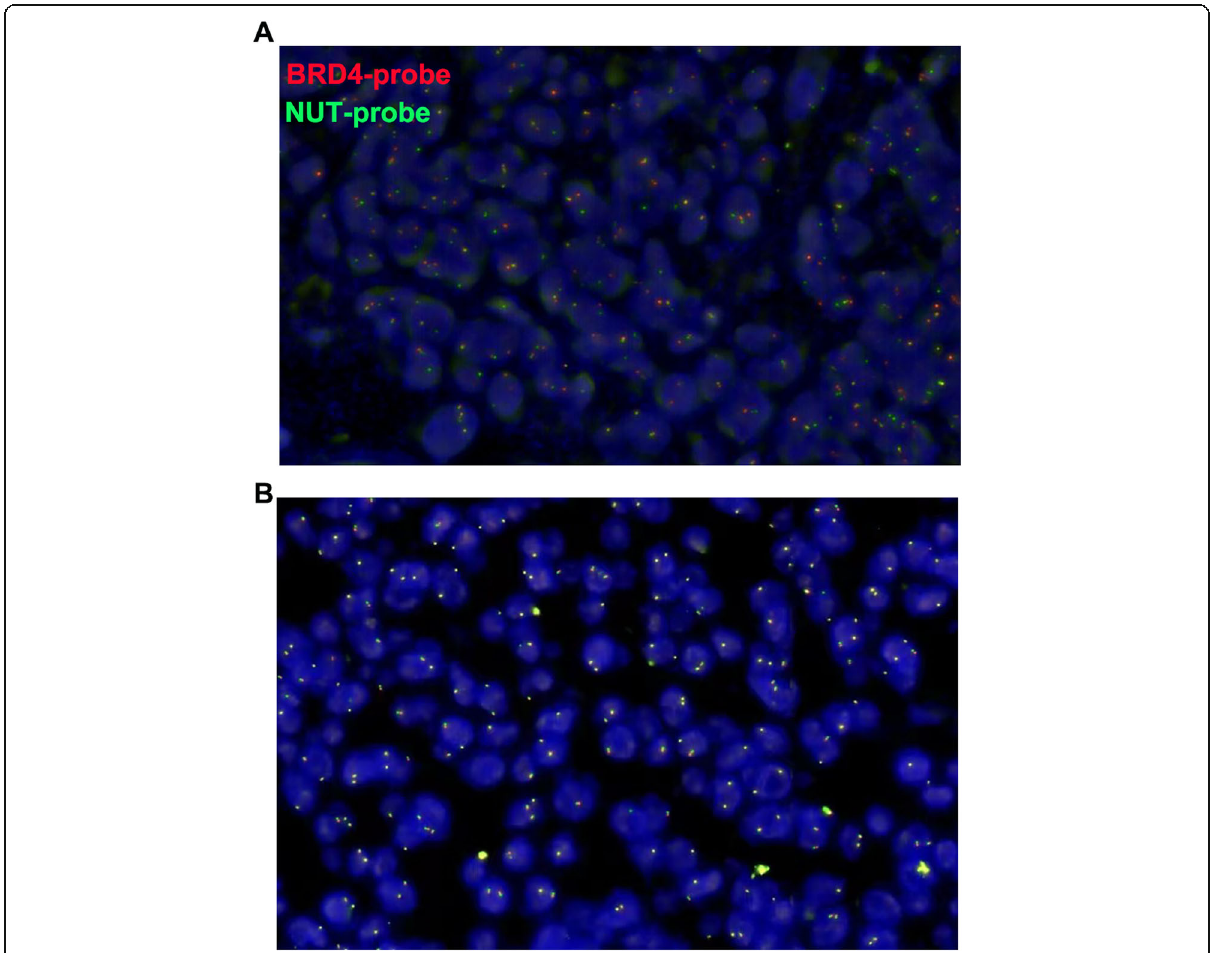
Fig. 2 A : Fluorescent DNA in situ hybridization (FISH) demonstrated a BRD4-NUT rearrangement. A : A red probe that spans NUT splits and joins the green BRD4 centromeric probe. B : A negative control. Scale bar = 50 μ